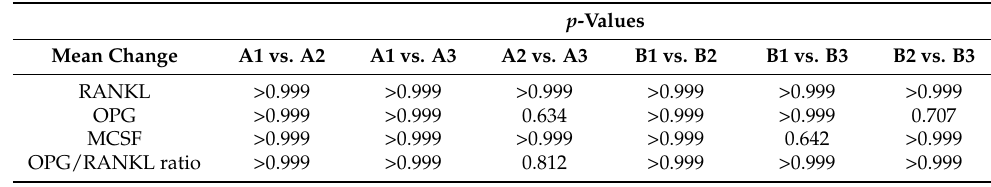
Table 4. Pairwise timing per group mean changes (final–initial) comparisons’ p ‐ values derived from linear regression models and adjusted for multiple comparison (Bonferroni).